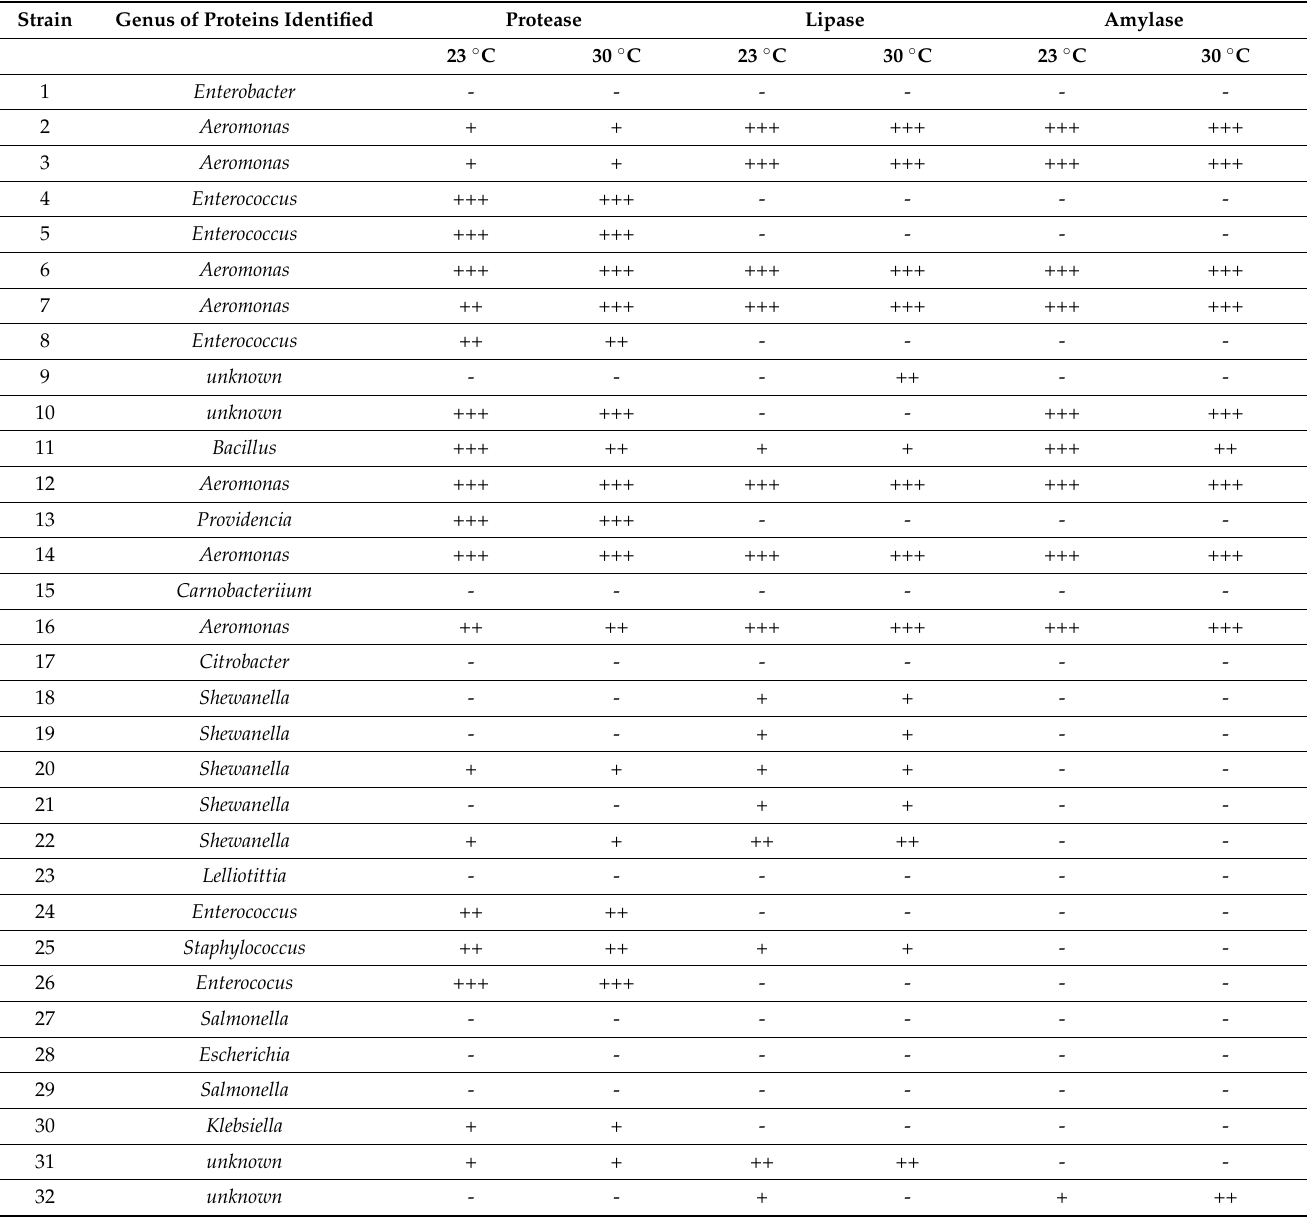
Table 3. Capacity of the isolates to produce macromolecule-degrading enzymes, such as protease, lipase, and amylase. (“+++”: strong activity; “++”: medium activity; “+”: low activity; “-”: no